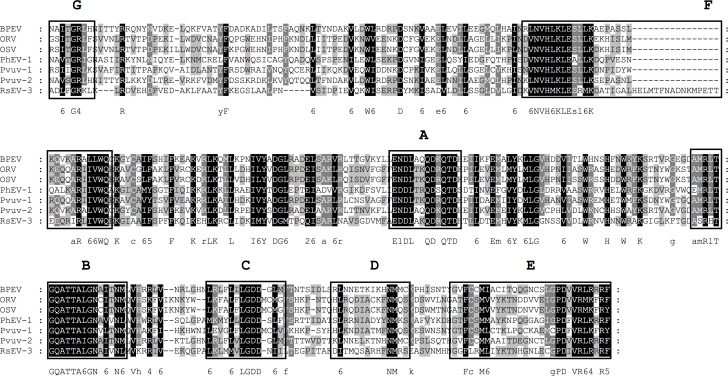
Identification of the conserved motifs A to G in the RdRp domain of the family Endornaviridae.The RdRp domains of the recognized members of the family Endornaviridae [8] and Rhizoctonia solani endornavirus 3 (RsEV-3) (KX349065) were aligned using MEGA 6.06 and the sequence alignment algorithm MUSCLE [45]. Conserved motifs A-G were marked according to Bruenn 2003, Černý et al. 2014, Koonin et al. 1993, Boehr et al. 2014 and Xu et al. 2003 [32, 36, 44–46]. BPEV, Bell pepper endornavirus (AKP92841.1); ORV, Oryza rufipogon endornavirus (YP_438202.1); OSV, Oryza sativa endornavirus (YP_438200.1); PhEV-1, Phytophthora endornavirus 1 (YP_241110.1); Pvuv-1, Phaseolus vulgaris endornavirus 1 (YP_009011062.1); Pvuv-1, Phaseolus vulgaris endornavirus 2 (ALJ56098.1). Shading indicates level of conservation and the consensus sequence is displayed.